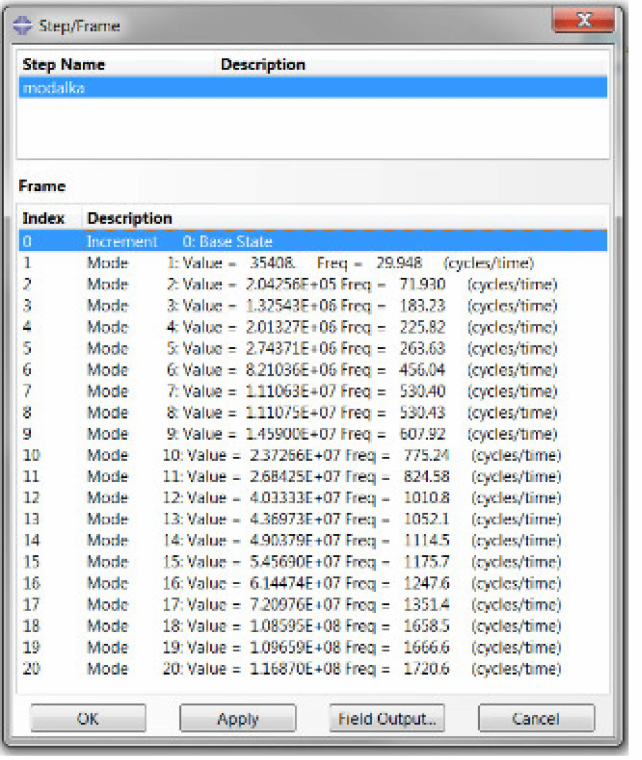
Figure 15. Eigenfrequencies of the modes determined by the FEM